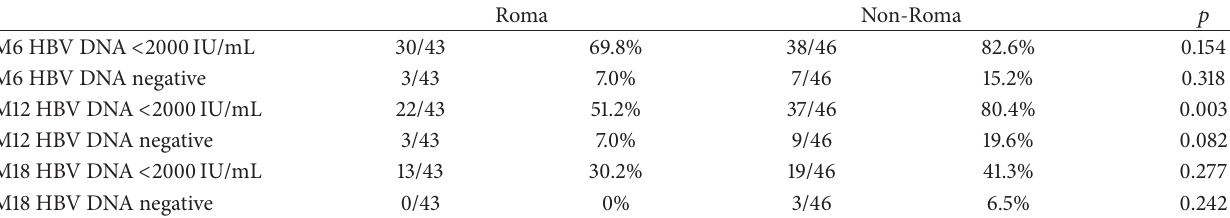
Table 4: HBV DNA during treatment and followup, real-world cohort.